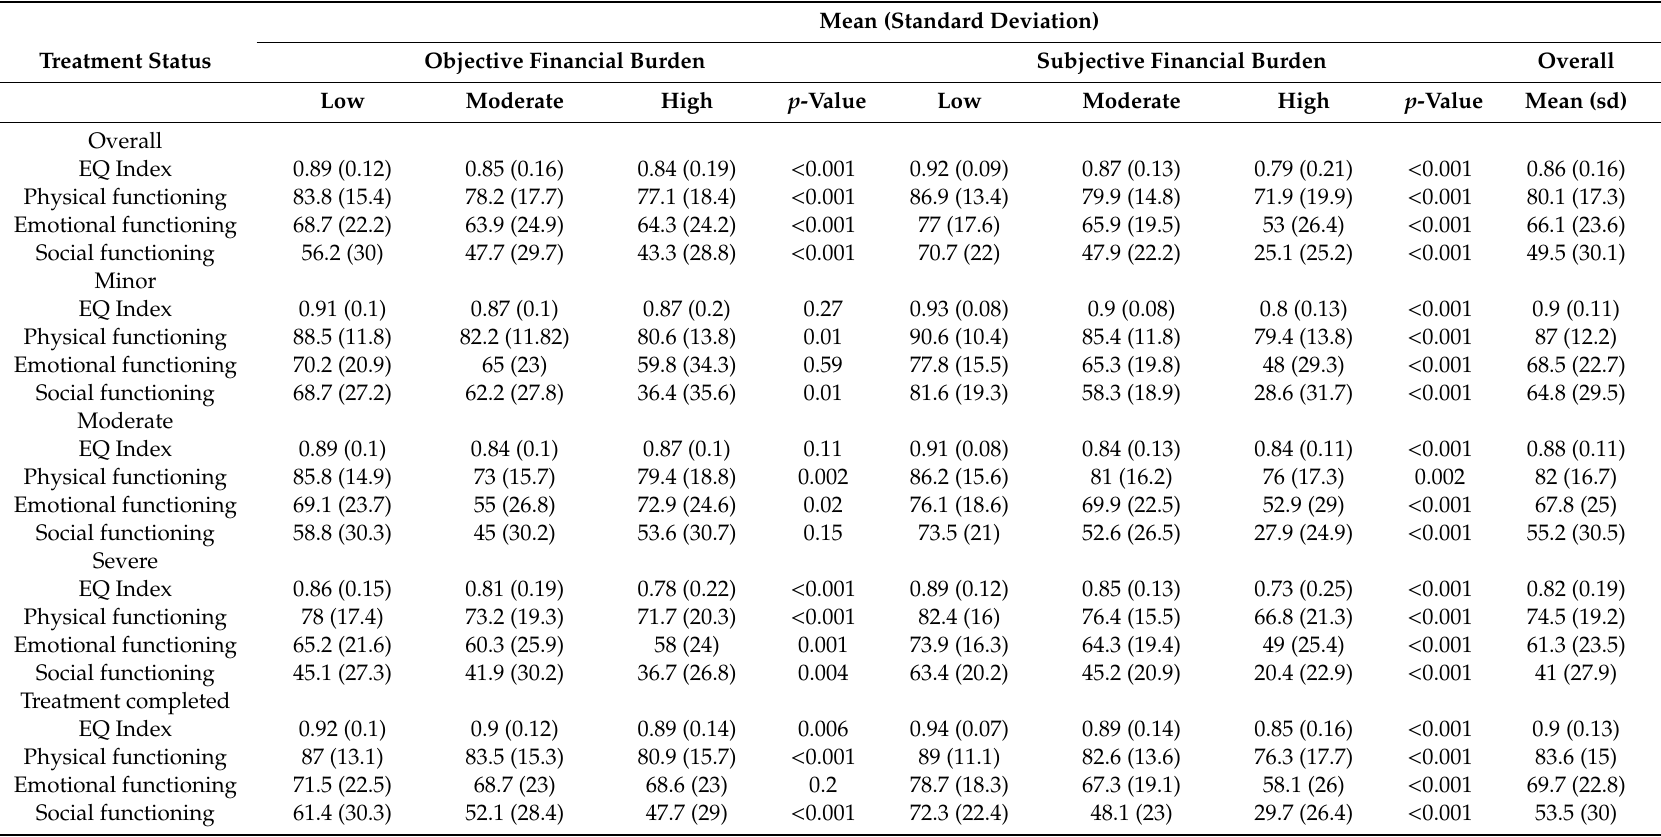
Table 3. Patients’ HRQoL stratified by financial burden and treatment